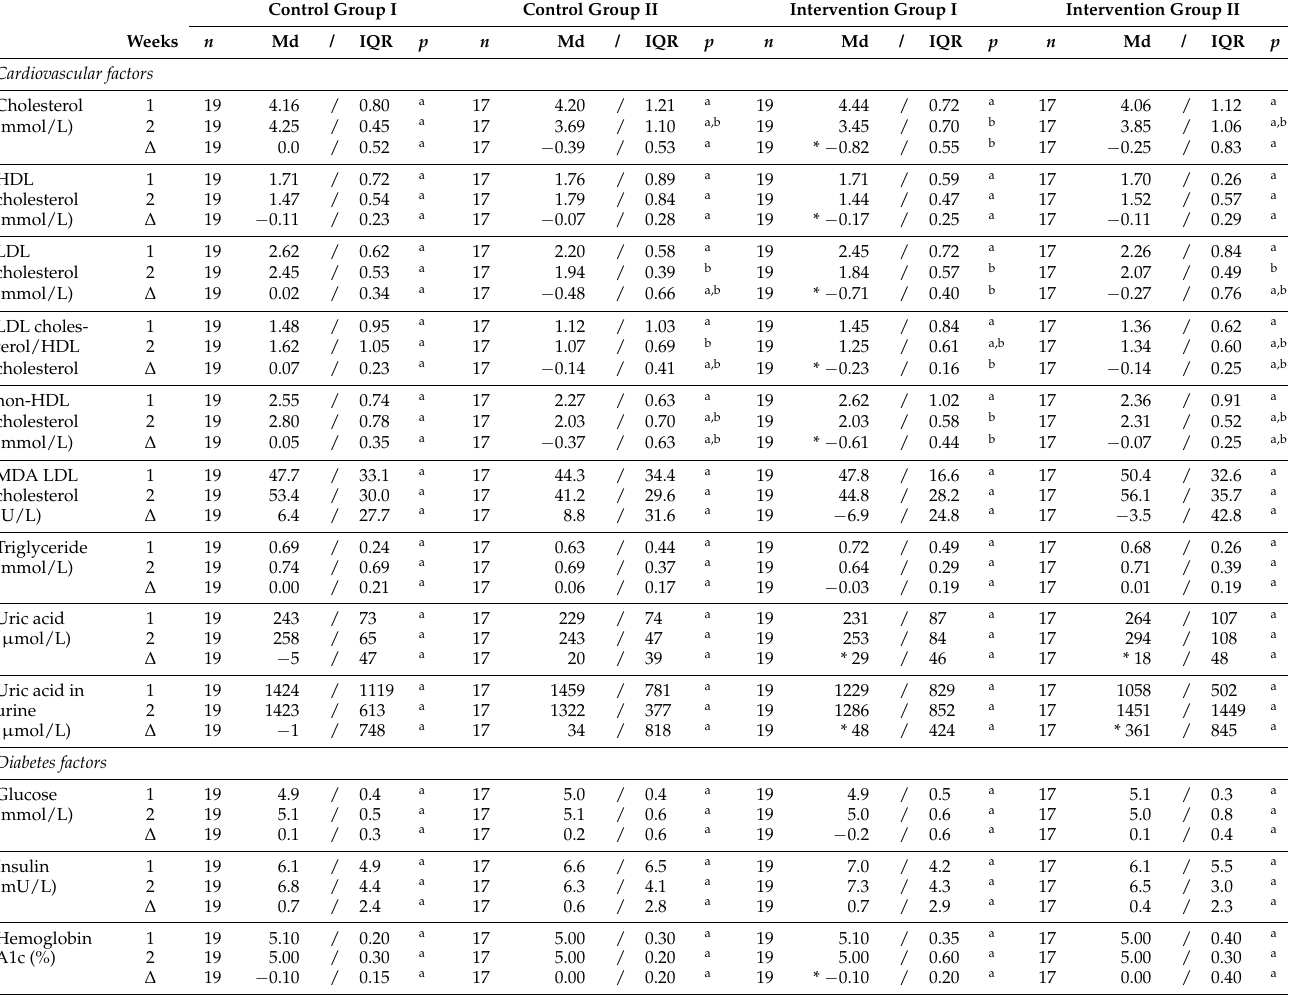
Table 6. Risk factors for cardiovascular diseases and diabetes mellitus type 2 of the NovAL study participants ( n =